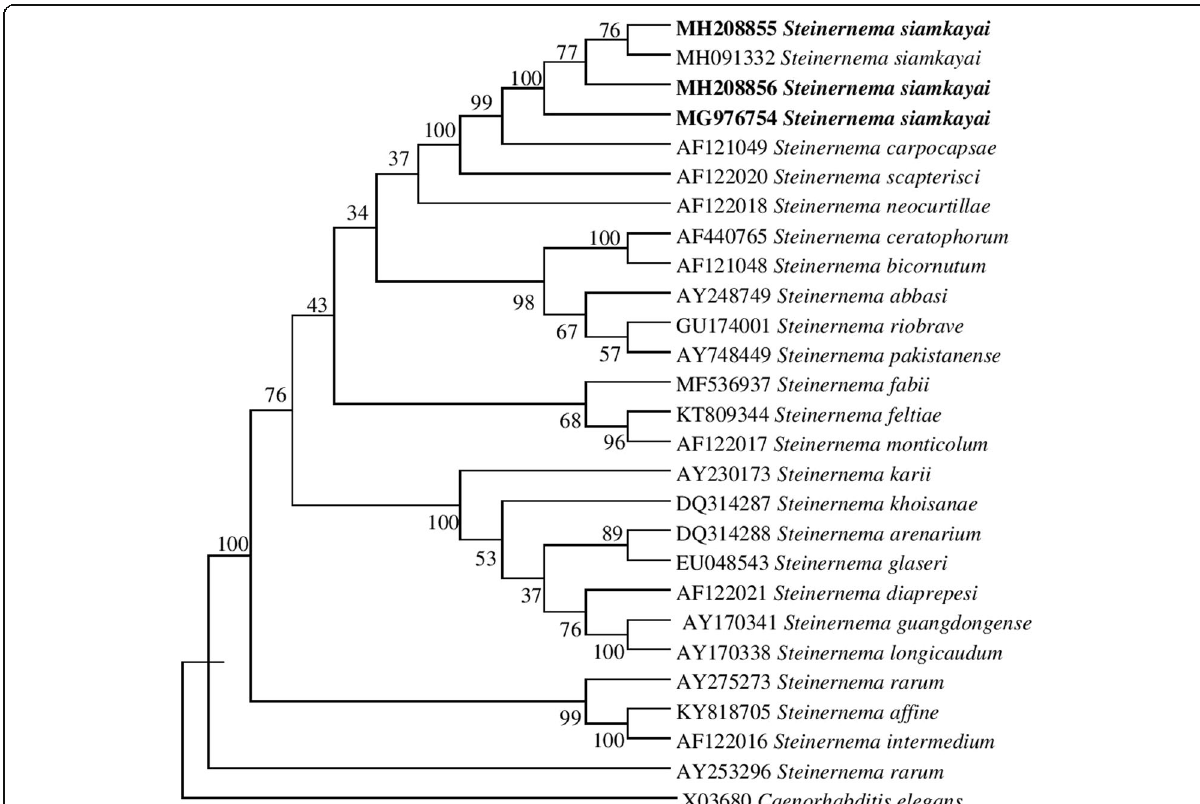
Fig. 2 Phylogenetic relationships of Steinernema siamkayai IIVR strains with other Steinernema spp. based on ITS-rDNA